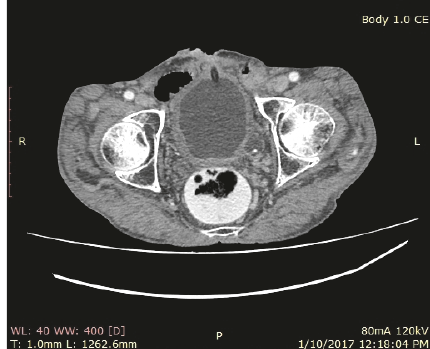
Figure 2: A contrast enhanced computed tomography scan image of suprapubic cystostomy site growth, transverse section.